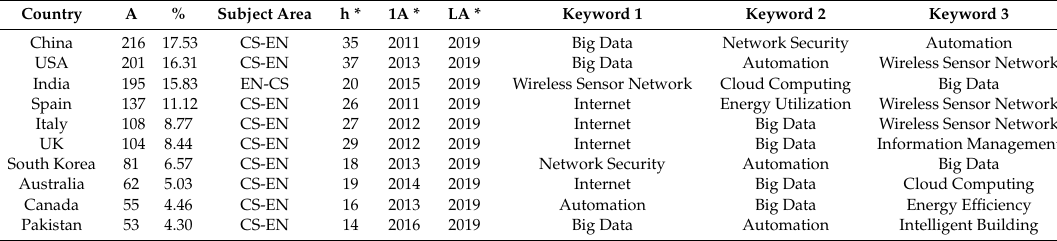
Table 15. Top 10 Countries and main keywords (2011–2019).